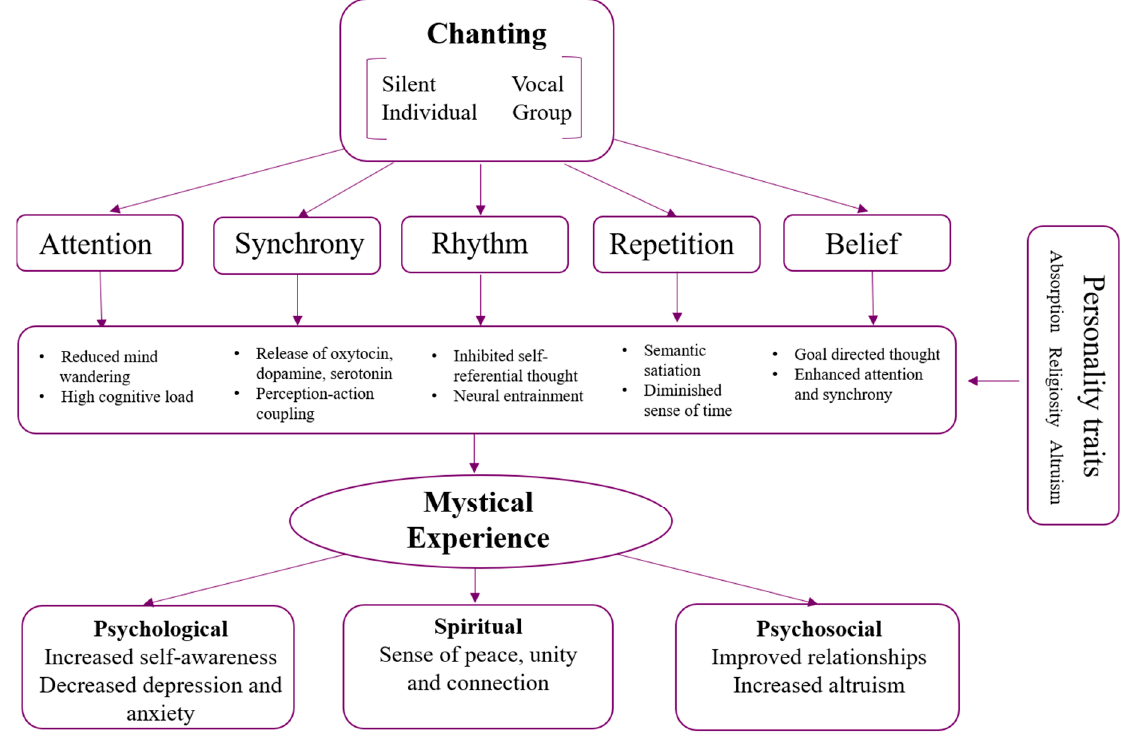
Figure 4. Model of chanting features, mechanisms, traits, and benefits that may arise from mystical states.